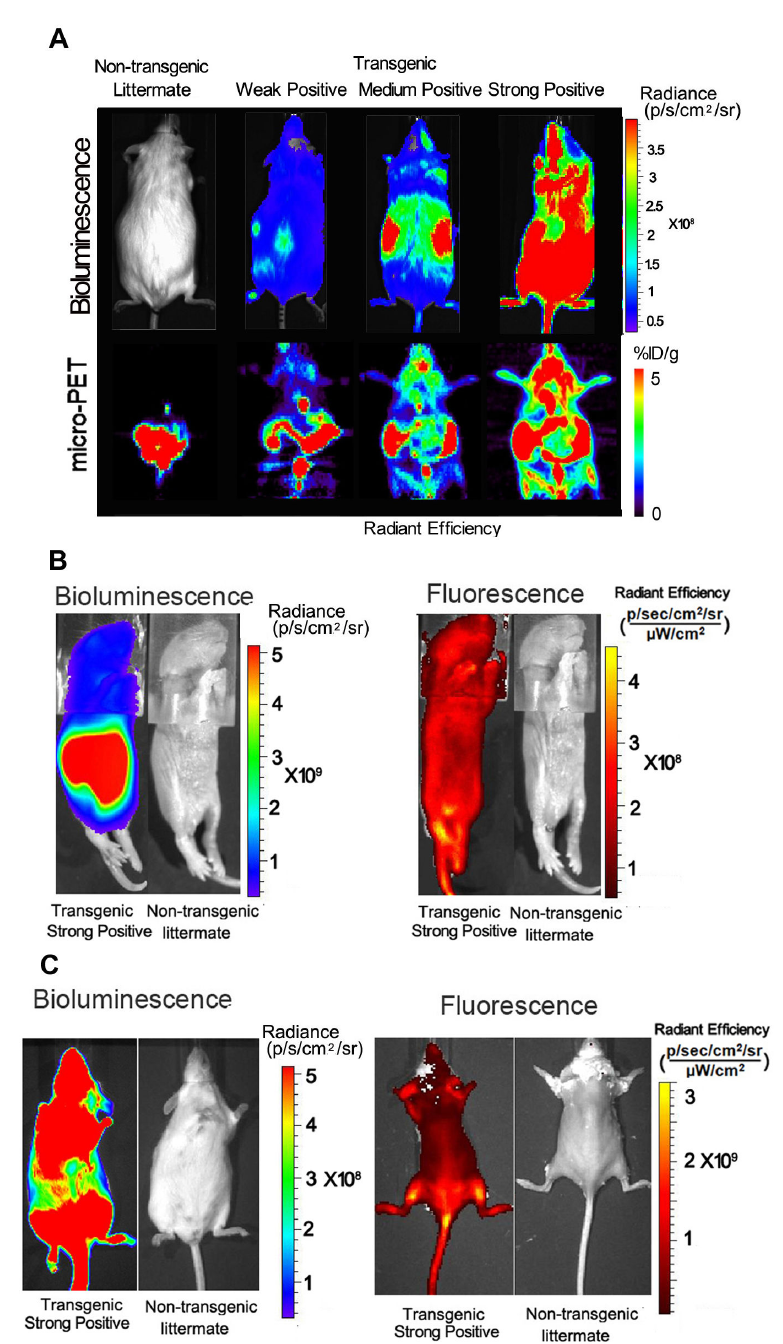
Figure 2. Characterization of tri-fusion transgenic mouse. (A) In vivo bioluminescence, micro-PET and fluorescence imaging of adult tri-fusion transgenic mice and non-transgenic littermate. Mice (N=15) with different expression levels of the tri-fusion reporter were scanned, and multimodality imaging results show that the expression level of all three genes are correlated with each other. No bioluminescence signal was found in non-transgenic littermate. Background micro-PET signal was found in heart and gastrointestinal system of non-transgenic littermate, and autofluorescence was also found in non-transgenic littermate. Transgenic positive mice show different signal levels in multimodality imaging due to the different gene expression levels. (B–C) In vivo bioluminescence and fluorescence imaging of strongly positive newborn and adult tri-fusion transgenic mice and non-transgenic littermates. Strong bioluminescence and fluorescence signals were found in tri-fusion transgenic mice, but not in non-transgenic littermates. p/s/cm 2 /sr=photons per second per cm 2 per steradian; % ID/g = percentage of injection dose per gram. doi: 10.1371/journal.pone.0073580.g002 PLOS ONE |